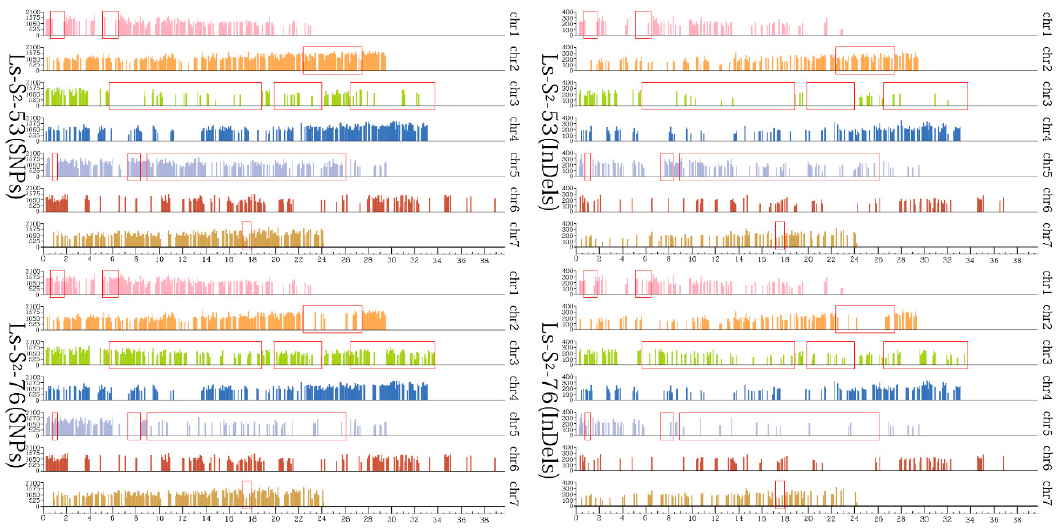
Figure 4. The specific distribution area of homozygous mutations (SNPs, indels) in Ls-S 2 -53 and Ls-S 2 -76 using a sliding window of 100 K with heterozygosity (<10%) as the parameter. The axis of abscissas and ordinates indicate the chromosomal location and number of variations, respectively. The different distribution areas of homozygous mutations were marked by the red rectangles and mainly distributed on chromosomes 2, 3, and 5.